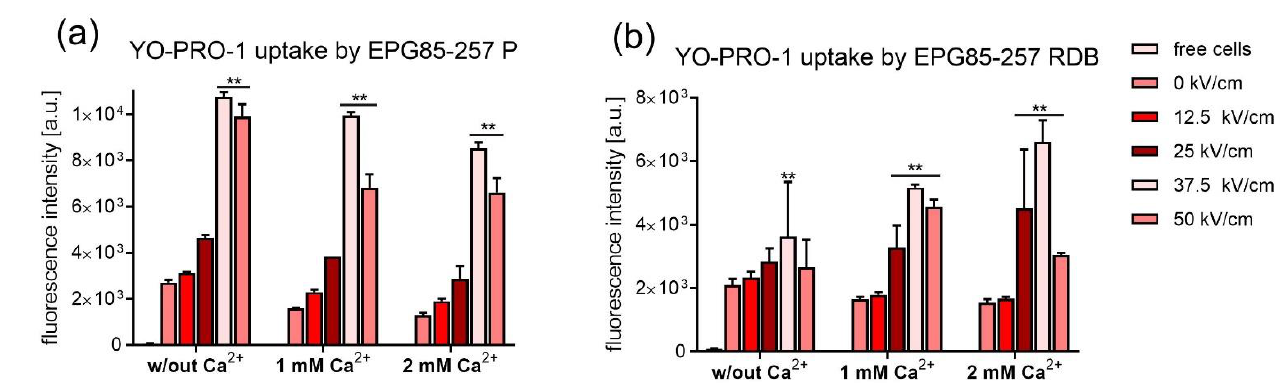
Figure 2. The evaluation of cell membrane permeabilization detected by YO-PRO-1 green dye uptake by ( a ) sensitive, and ( b ) drug-resistant cells. Data are mean ± SD (n = 3 independent experiments and technical repetitions), ** p ≤ 0.05.